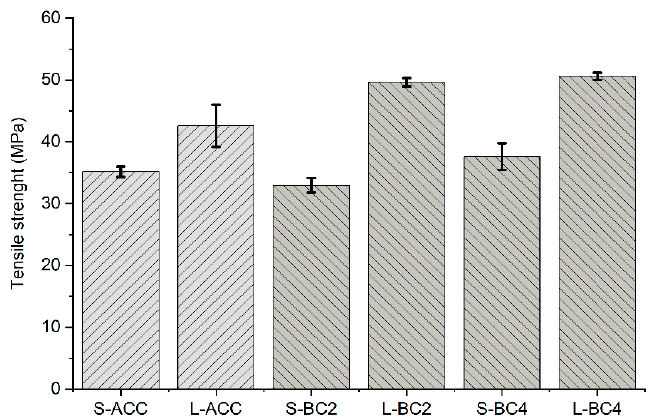
Figure 2. Tensile strength (MPa) for ACC and PP reference biocomposites. Tensile strength measurements were performed in two directions, where S stands for the Spinnova–Lyocell (weft) direction and L stands for the Lyocell (warp) direction. Lighter shade is used for ACC, darker for